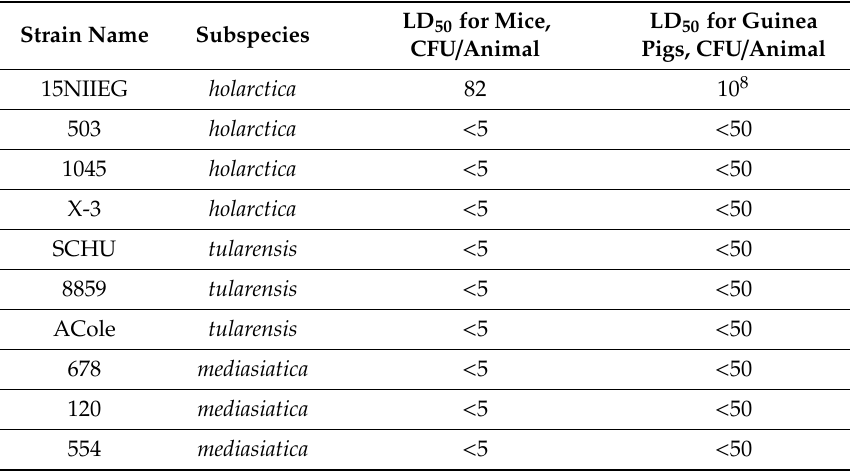
Table 1. Strains of F . tularensis used in the present